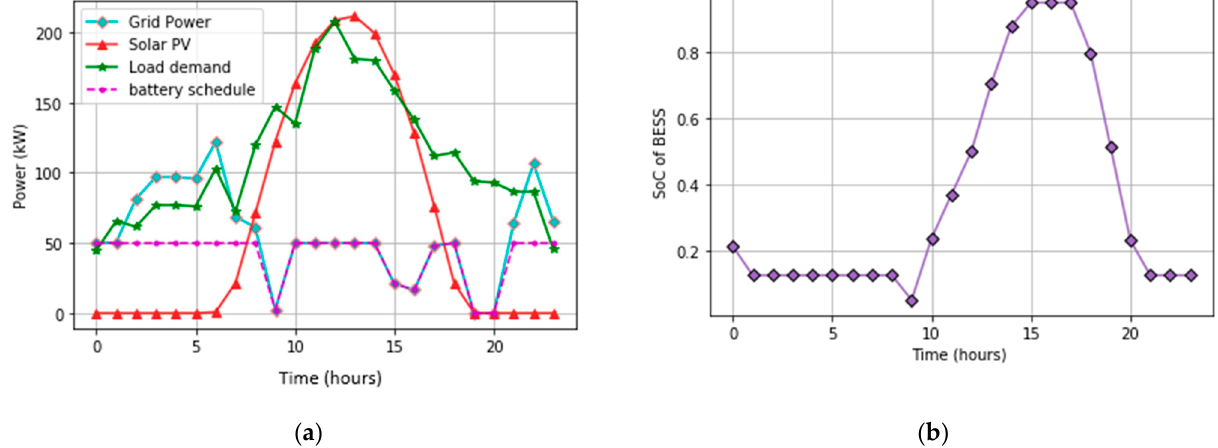
Figure 5. Observations with grid constraints; ( a ) Optimized energy schedule. ( b ) Tendency of the SoC of the BESS.